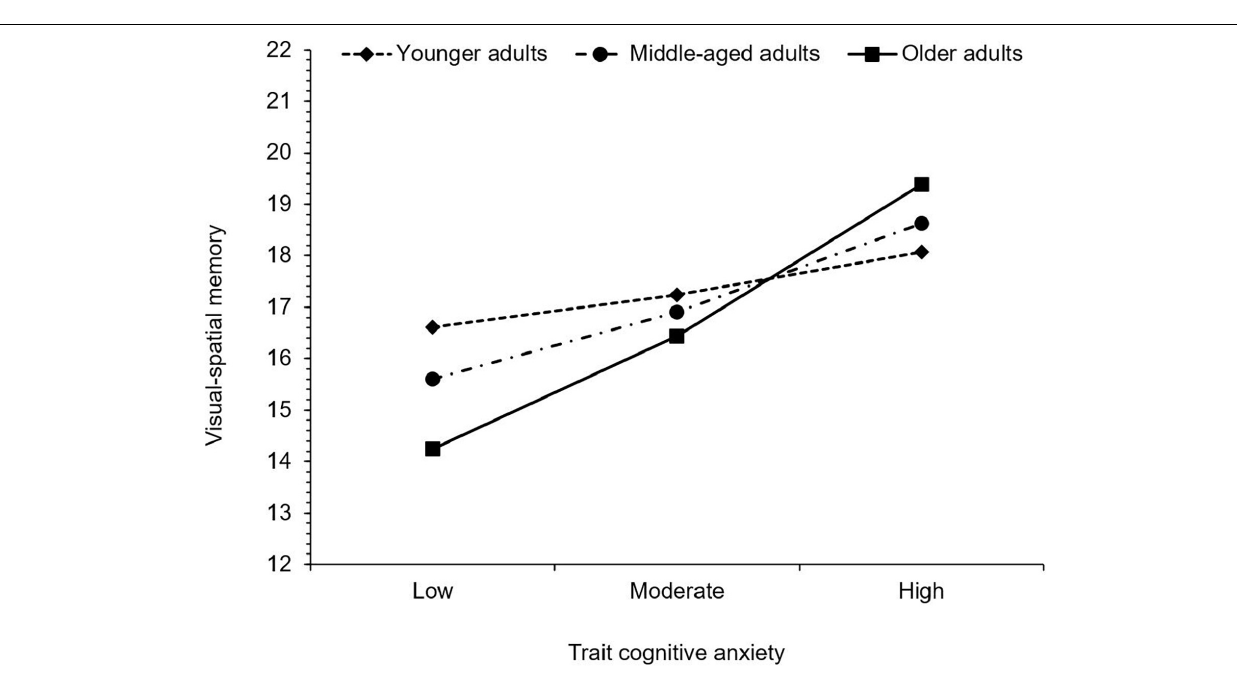
FIGURE 4 | Simple slopes illustrating the significant interaction between trait cognitive anxiety and age on visual − spatial memory. Higher values indicate greater levels of subjective cognitive difficulty.